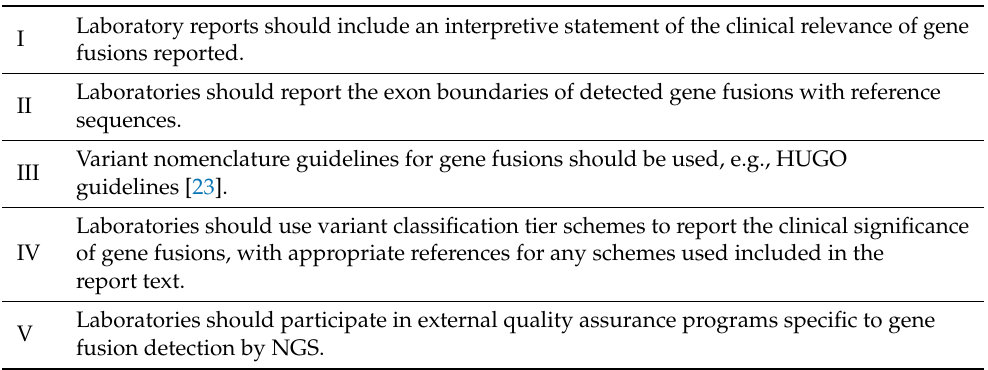
Table 3. Summary of post-analytic and reporting recommendations for RNA-based NGS for gene fusion